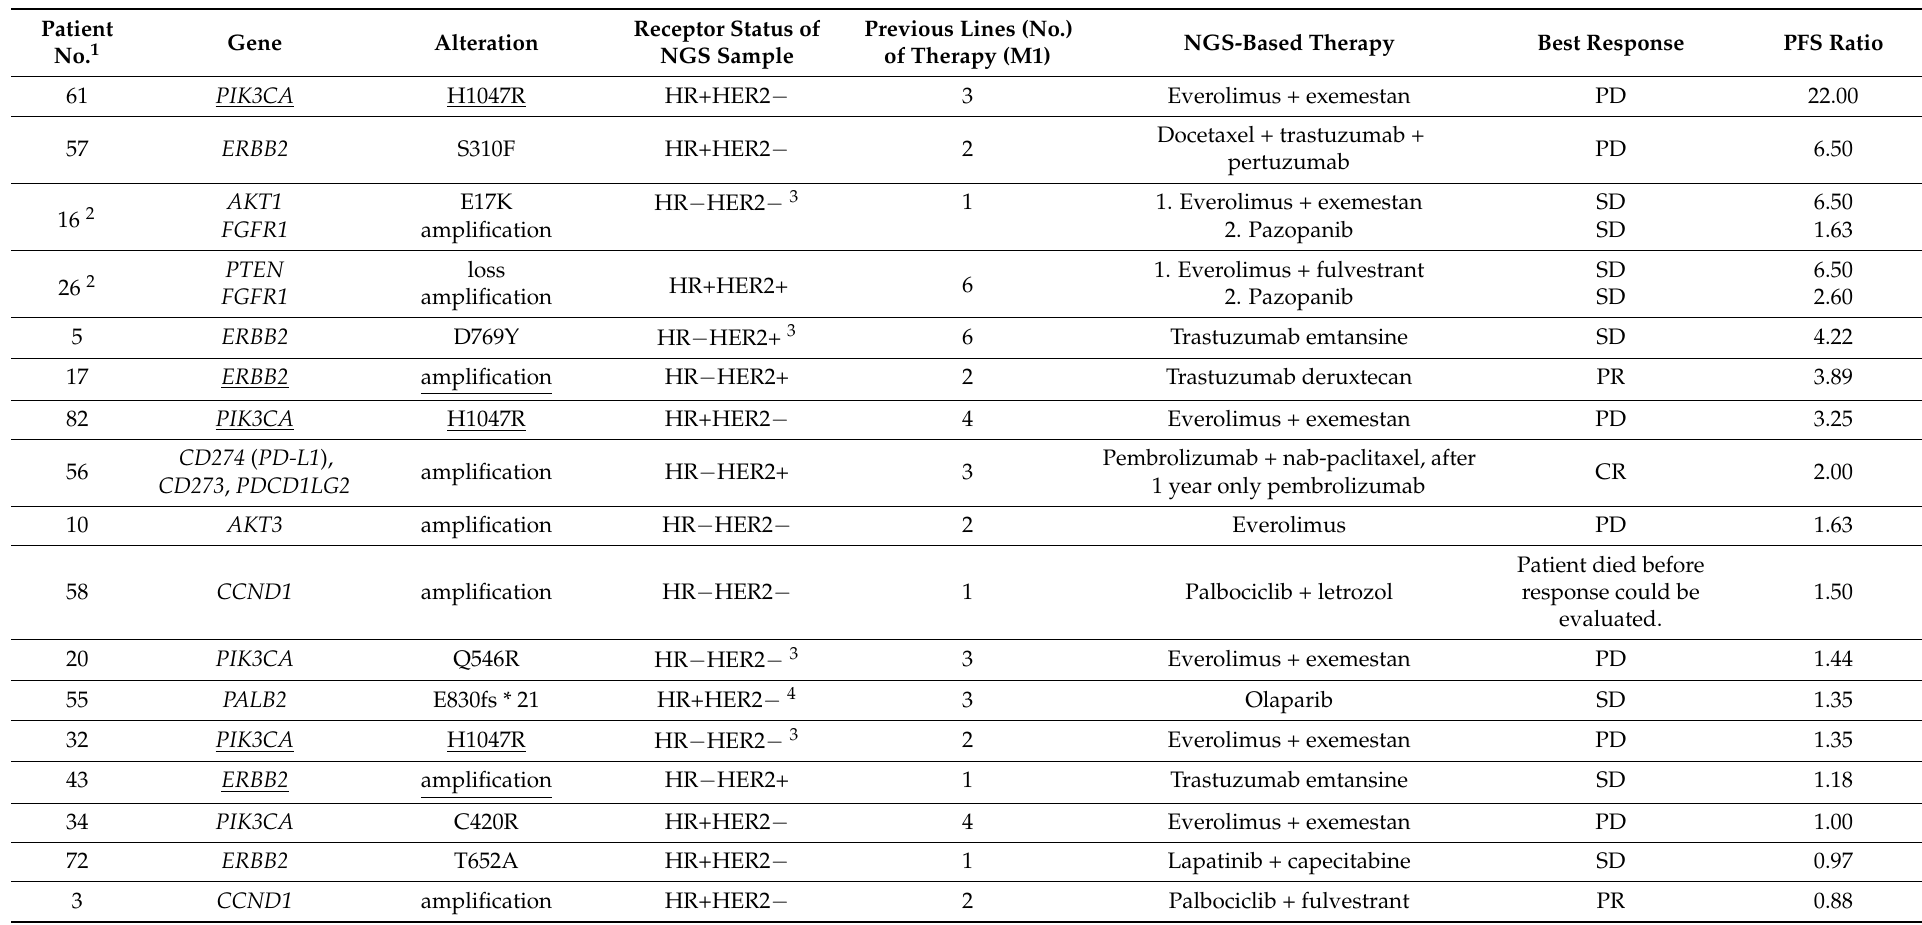
Table 2. Next-generation sequencing (NGS)-based treatment and indication of best response in 30 patients with mBC. Underlined gene alterations represent the ESMO Scale for Clinical Actionability of molecular Targets (ESCAT) level IA [24]. The progression-free survival (PFS) ratio was calculated as PFS under the NGS-recommended treatment (PFS2) to PFS under the immediate previous standard treatment line